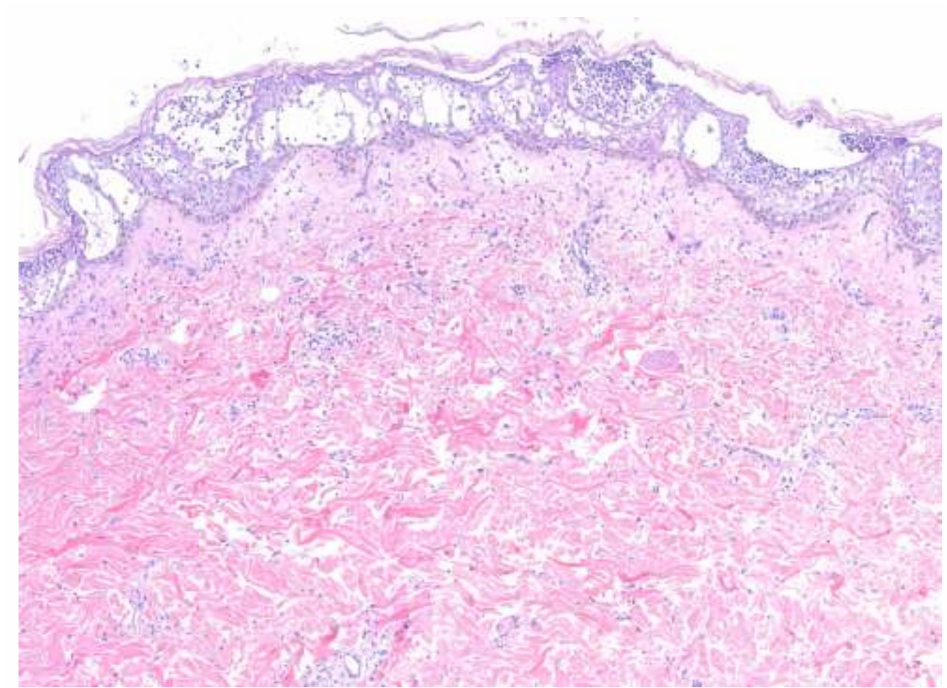
Figure 4. Acute generalized exanthematous pustulosis. Spongiform pustules and papillary dermal edema are consistent features. Orthokeratosis reflects the acuity of this